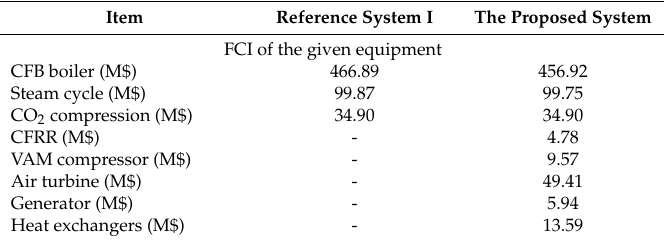
Table 9. Economic performance of the reference system I and the proposed